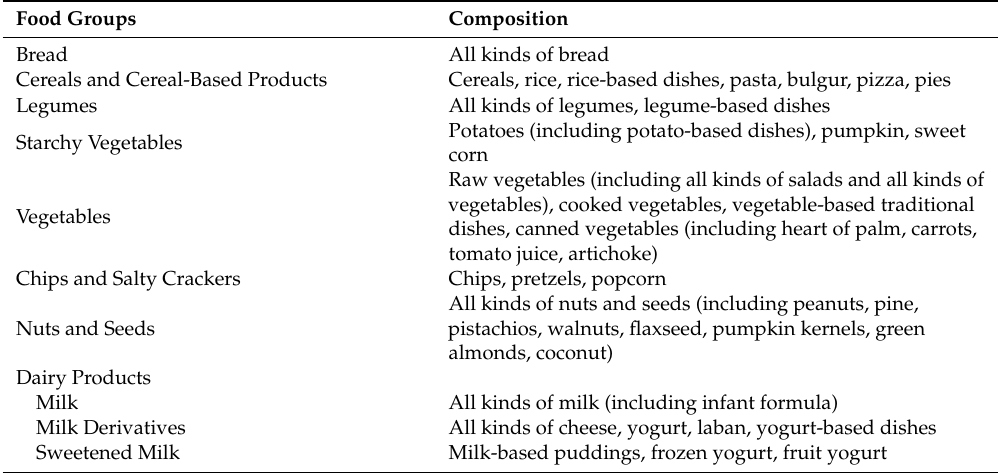
Table A1. Composition of each food